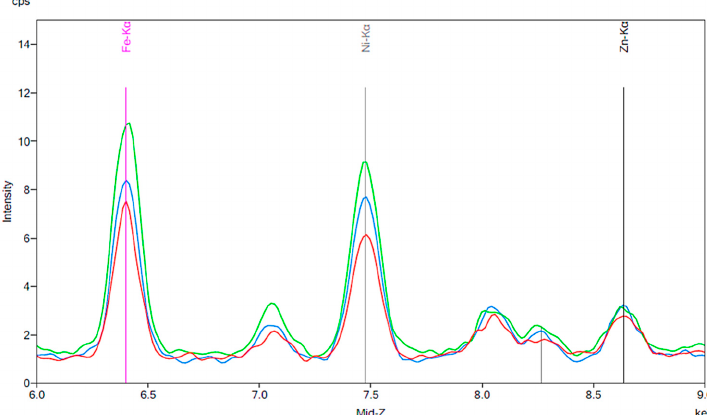
Figure 10. The results of an experiment in which artificial teeth were exposed to tea for 24 h. These teeth were then cleaned with a toothbrush for 30 s. The red peak represents the artificial tooth before exposure to tea. The green peak corresponds to the same tooth following 24 h exposure to tea. The blue peak represents the same tooth that had been exposed to tea following 30 s of brushing.